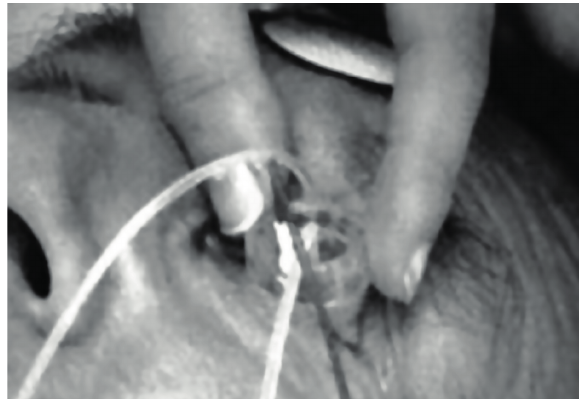
Figure 6 - Use of iontophoresis for ocular treatment Source: Modi fi ed from Fialho et al.